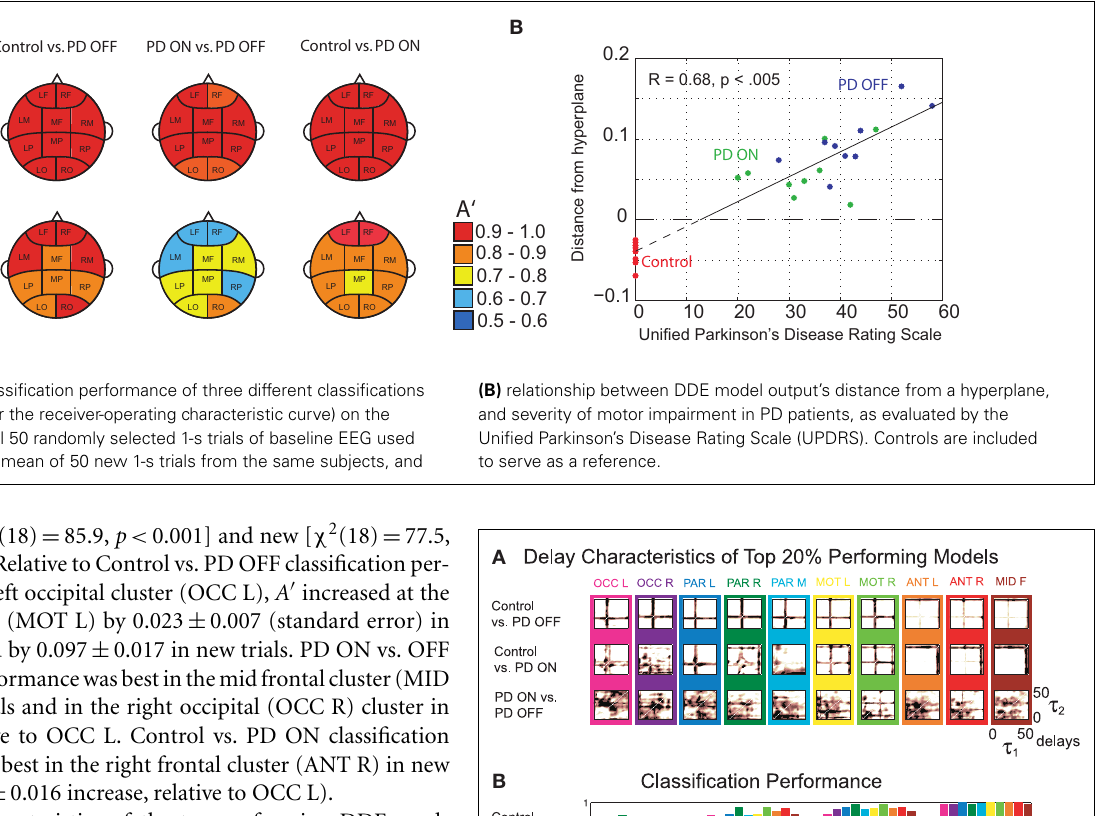
FIGURE 5 | (A) Time delay characteristics of top 20% performing models, and (B) classification performance of three different classifications using A (cid:48) on the mean of the original 50 1-s trials, using 1, 5, 10, and 30 combined models.